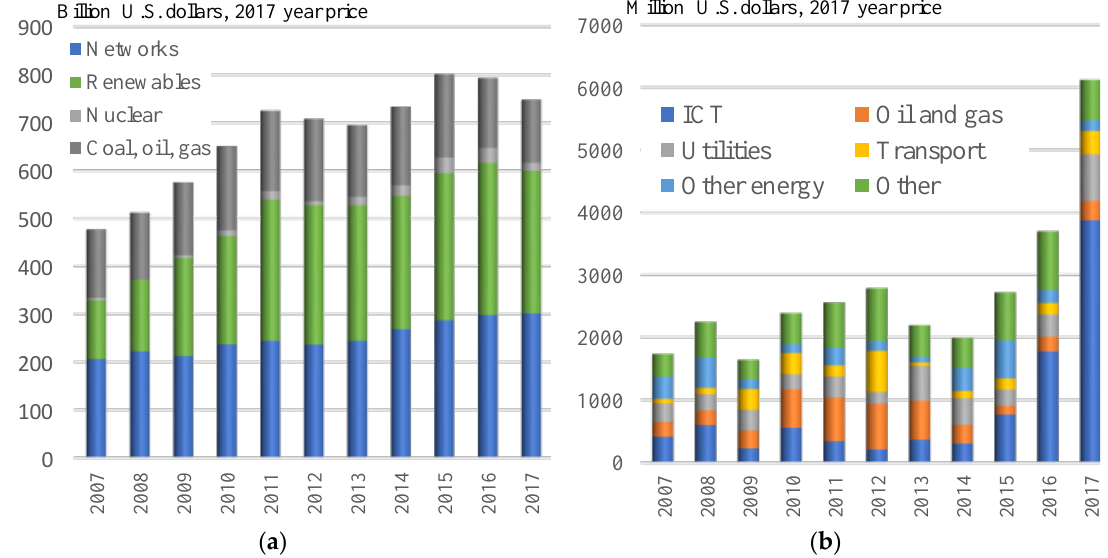
Figure 1. The investment trend related to the energy sector. ( a ) Investment by global power sector; ( b ) Corporate investment in new energy technology companies, by sector of investing company. (Source: IEA World Energy Investment 2018).